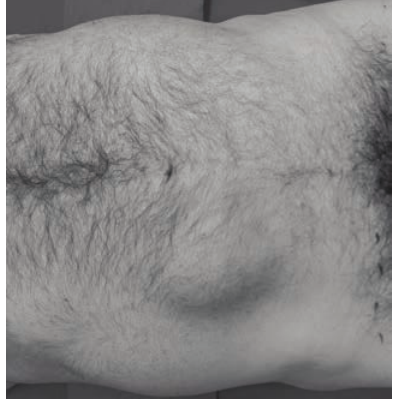
Figure 1. Swelling in the lower abdomen at the right abdominal rectus muscle, below the umbilicus.